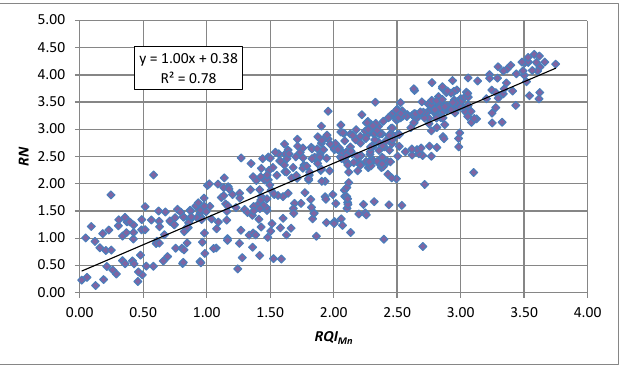
Figure 2. Correlation between RQI Mich and RN .